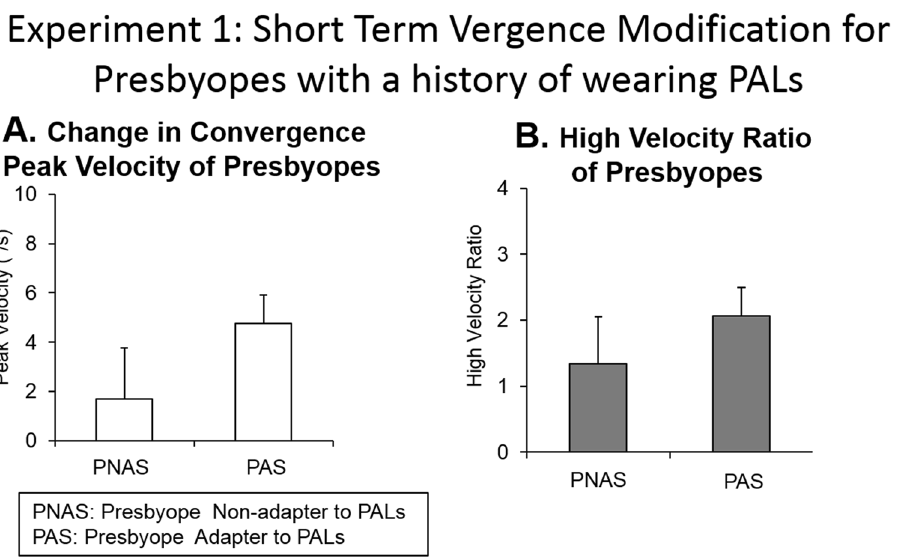
Figure 4. ( A ) Change in convergence peak velocity and ( B ) High-velocity component ratio for the eight individual subjects who did not adapt to PALs (PNAS) and the eight subjects who adapted to PALs (PAS). Group level summary plots are shown as the average with one standard